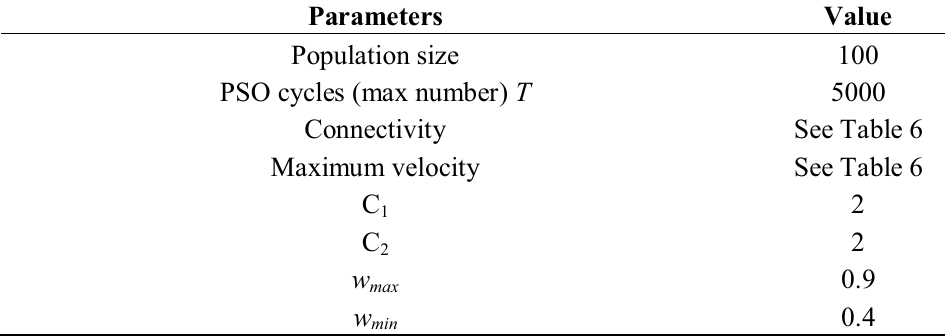
Table 5. The test parameters for the Particle Swarm Optimization (PSO) [38].